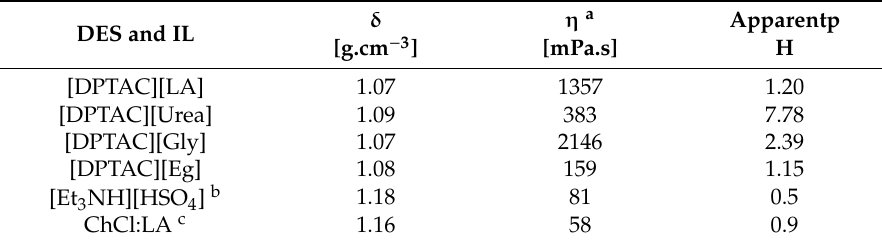
Table 1. Physicochemical properties of DESs and the IL used in this study. δ η a Apparentp DES and IL [g.cm − 3 ] [mPa.s] H [DPTAC][LA] 1.07 1357 1.20 [DPTAC][Urea] 1.09 383 7.78 [DPTAC][Gly] 1.07 2146 2.39 159 1.15 ChCl:LA c 1.16 58 0.9